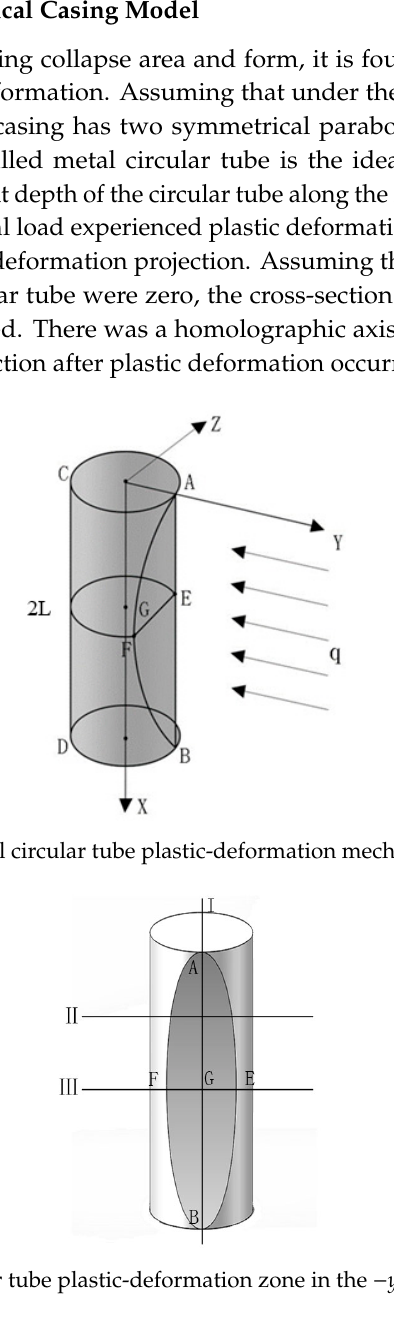
Figure 2. Simulation of casing deformation by the finite element method.